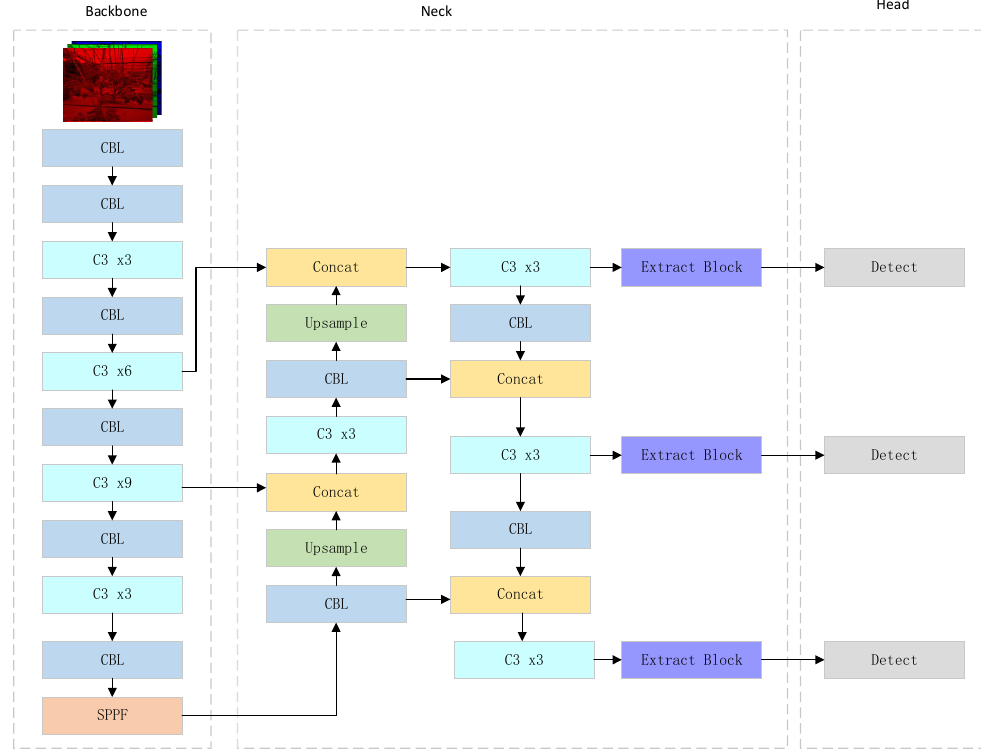
Figure 6. The architecture of the improved YOLOv5.